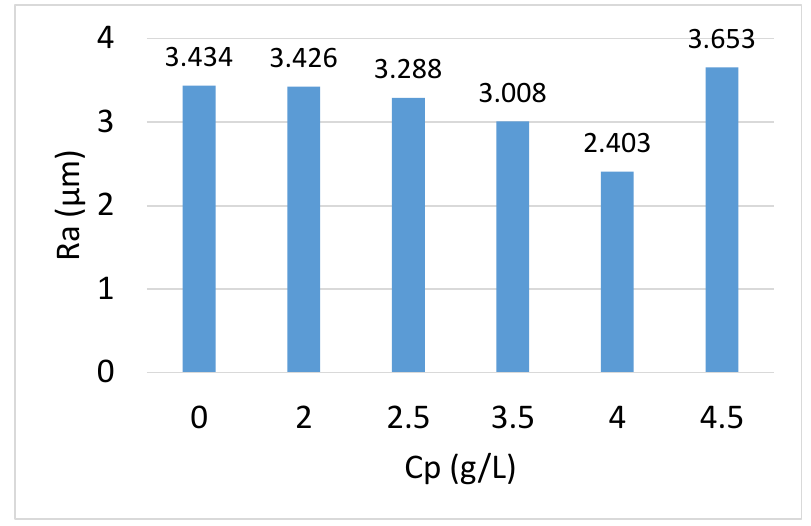
Figure 8. E ff ect of C p on the roughness.